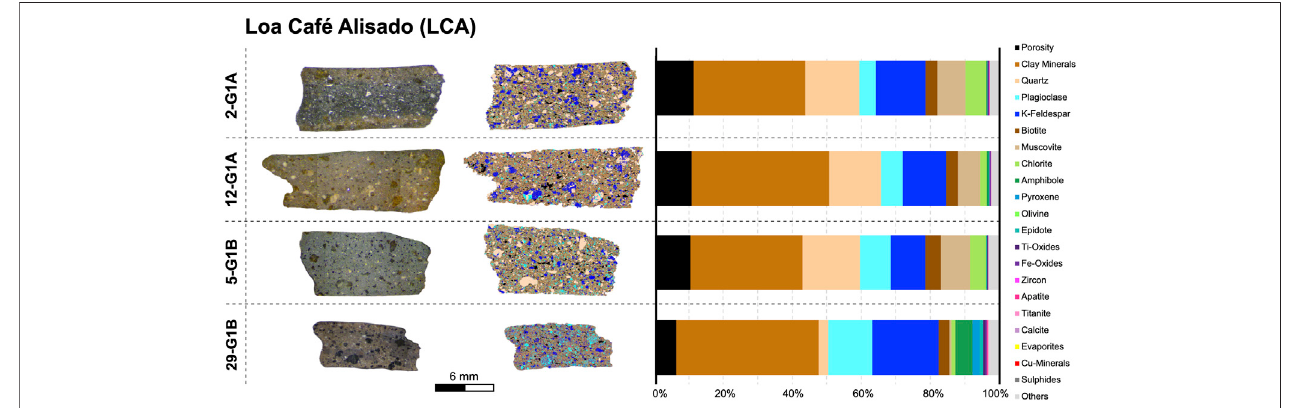
FIGURE 7 | Fresh pastes (left), mineralogical maps (middle), and modal mineralogy (right) of the studied Loa Café Alisado (LCA) ceramic samples.